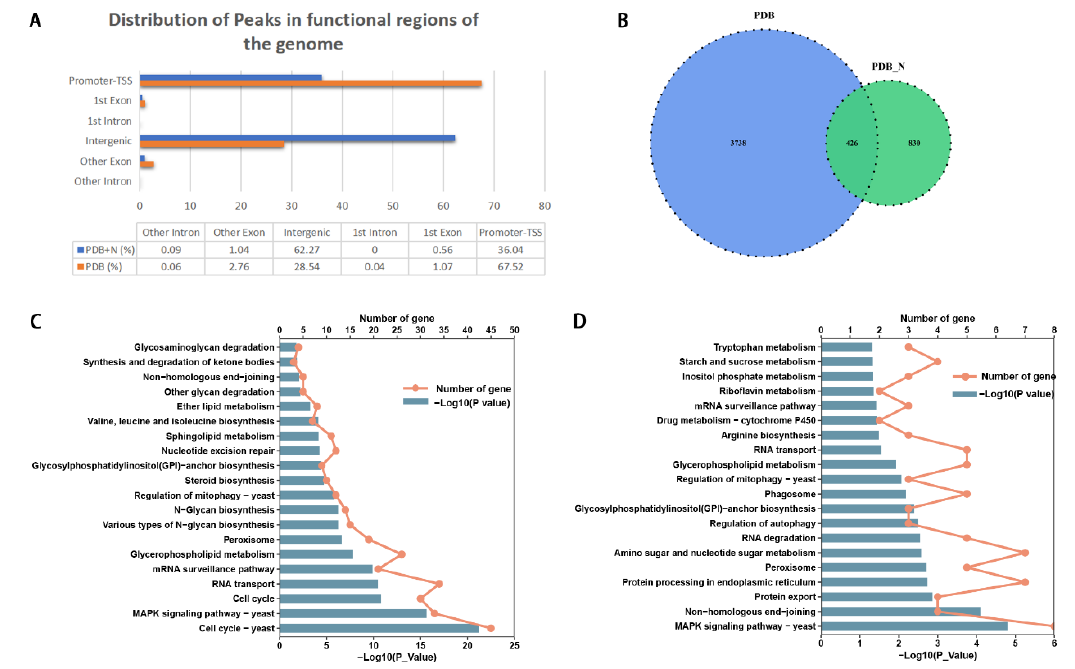
Figure 4. Histone H3K14 acetylation regulates gene expression affecting the growth and conidiation of P. lavendulum ( A ) Distribution of peaks in functional regions of the genome. ( B ) a Venn plot comparing gene numbers associated with H3K14 acetylation modification. ( C , D ) KEGG enrichment of genes associated with H3K14ac from the PDB ( C ) and PDB with ammonia sulfate ( D ) cultured samples.